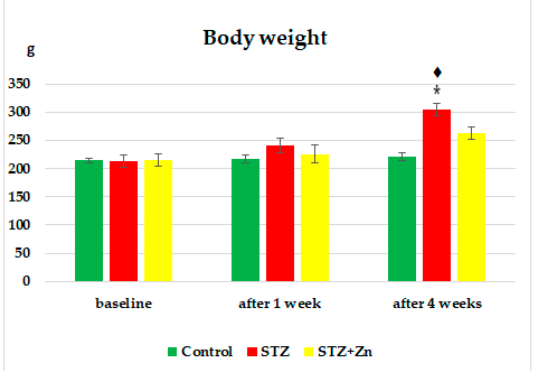
Figure 1. Effects of Zn on the body weight of diabetic rats. The values are presented as mean ± S.D. for 5 animals in a group (STZ—streptozotocin, STZ+Zn—steptozotocin + zinc). * p < 0.05 versus control; ♦ p < 0.05 versus baseline.